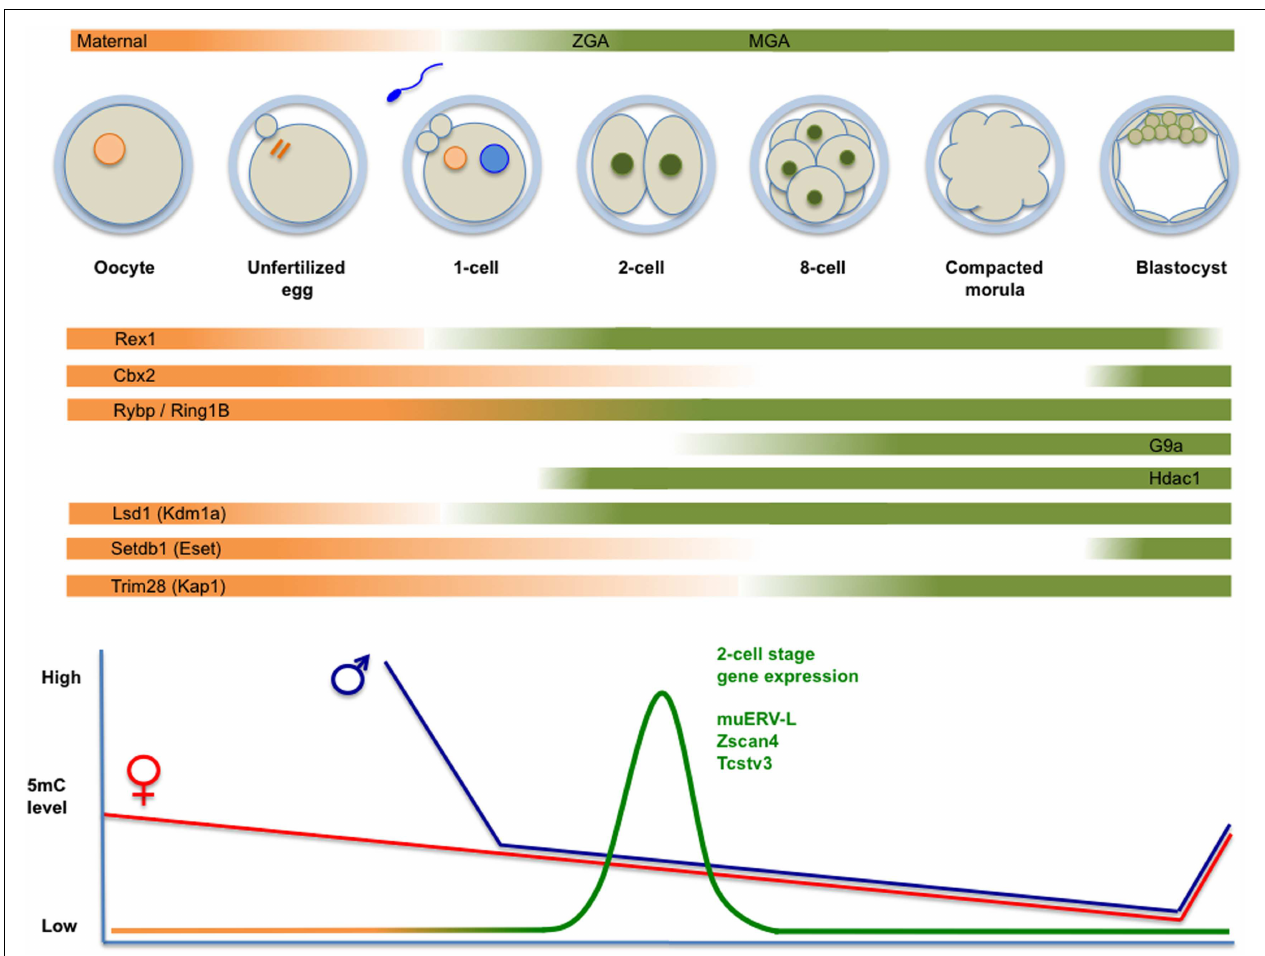
important chromatin modifiers are indicated. Bottom panel: time course of genome-wide (de)methylation. By the time of implantation, DNA methylation is re-established andTE are rapidly silenced. Demethylation is not uniform, i.e., certainTE (i.e., IAP) and imprinted loci are protected from demethylation. The diagram also shows a peak of unique expression of muERV-L, Zscan4, Tcstv3, and others in two-cell